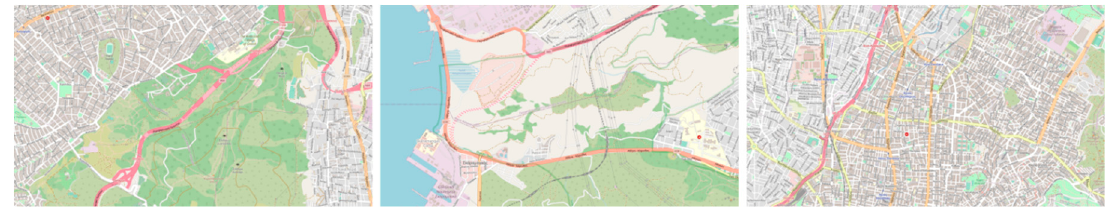
Figure 2. Visual stimuli used for the demo experiment.